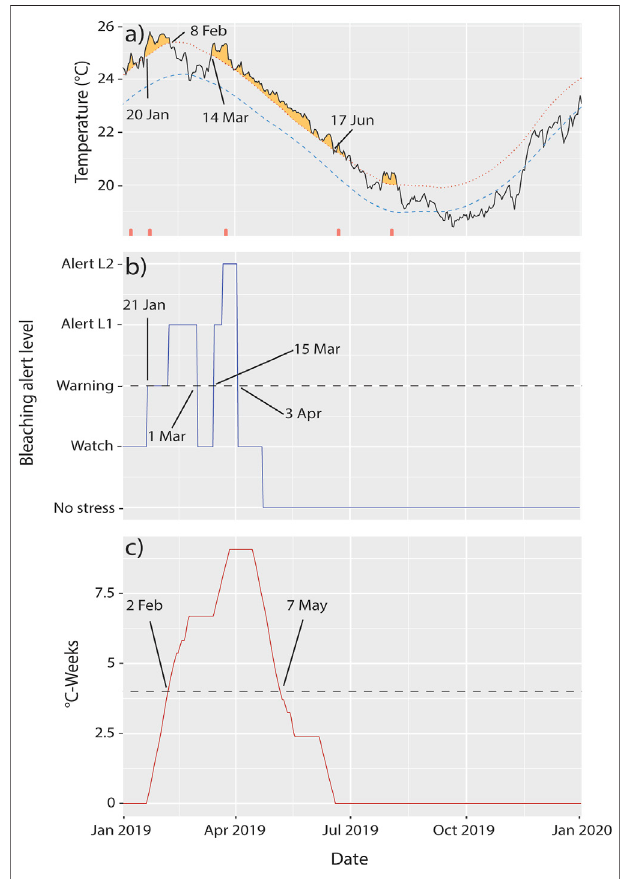
FIGURE 2 | Extreme temperatures at Lord Howe Island in 2019. (A) Heatwaves [plot downloaded from the Marine Heatwave Tracker (Schlegel, 2020)], (B) Coral Reef Watch bleaching alert levels, and (C) degree heating weeks at Lord Howe Island in 2019. The dashed lines in (B,C) represent minimum conditions at which bleaching is expected to